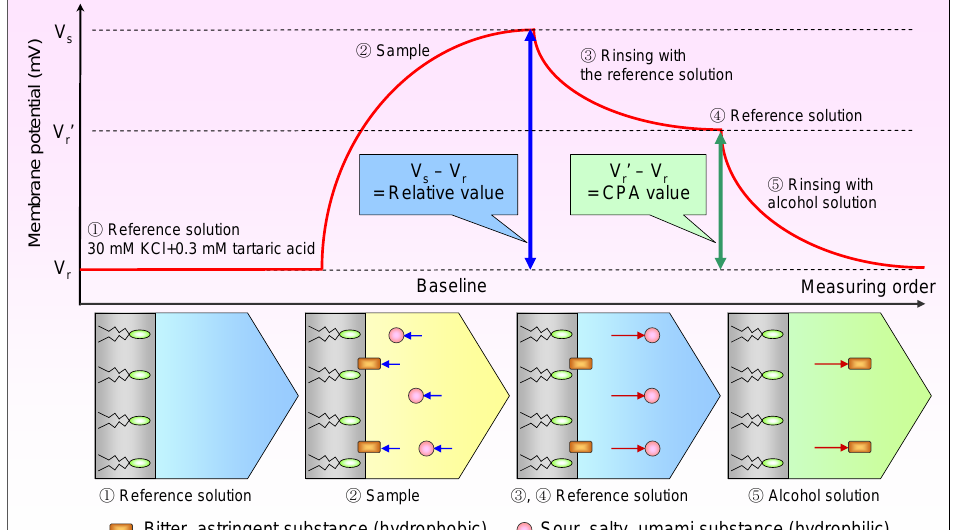
Figure 6. Measurement procedure. *Note: The reference solution should be tasteless compared to the measured sample. Therefore, the reference solution should have a lower concentration for samples with extremely low concentrations (e.g., 1 mM KCl in Figure